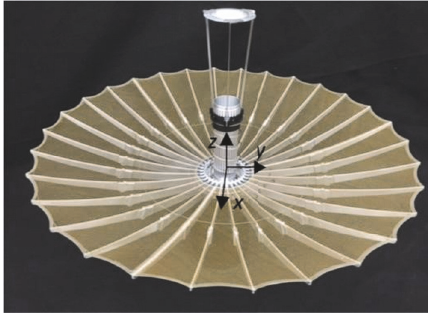
Figure 9: Mechanical deployment [71].